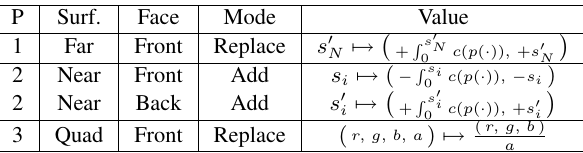
Table 1: Summary of the 3 draw passes P1, P2 and P3 used to render an uncertain scene bounded by near and far surfaces, un- der a uniform probability on the projected points on the sampled